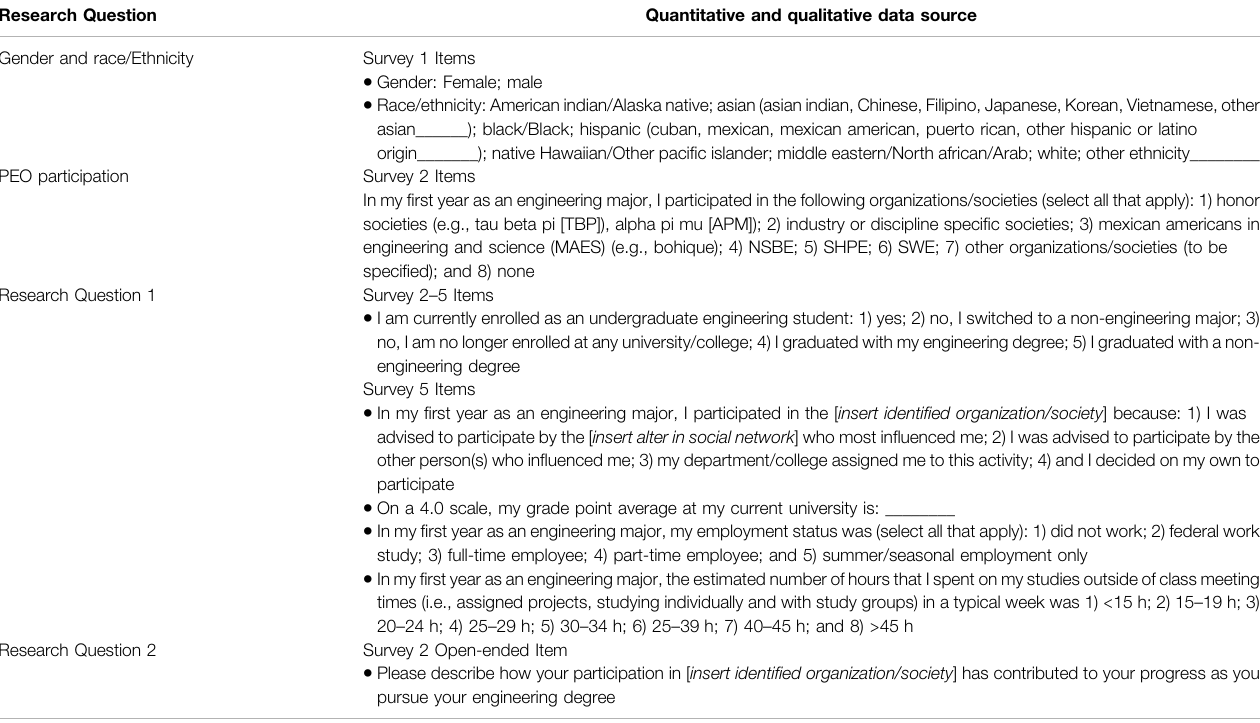
TABLE 2 | Quantitative and Qualitative Data